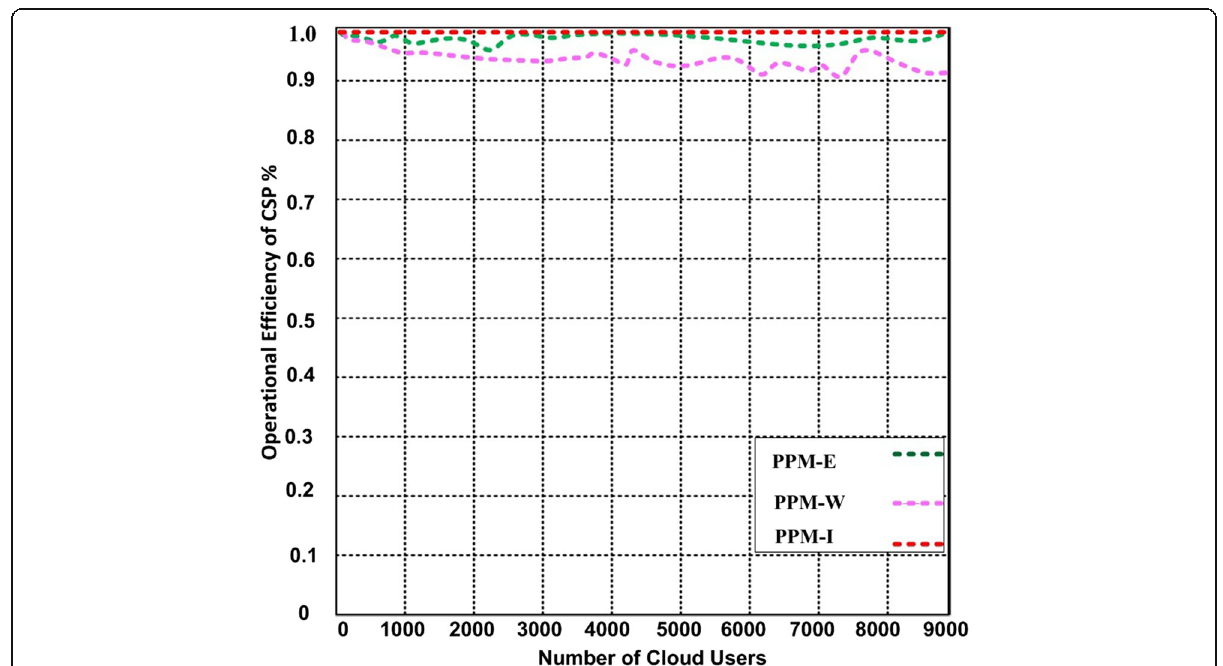
Fig. 9 Operational Efficiency VS number of cloud users (for a relatively smaller cloud